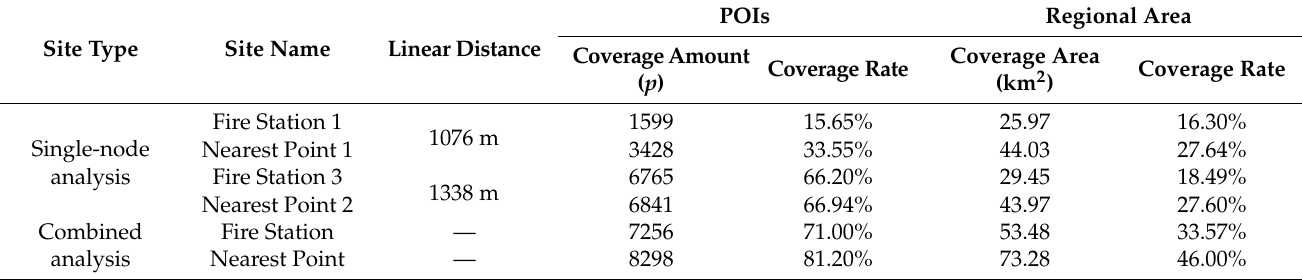
Table 2. Coverage of POIs and area by fire stations and nearest points.